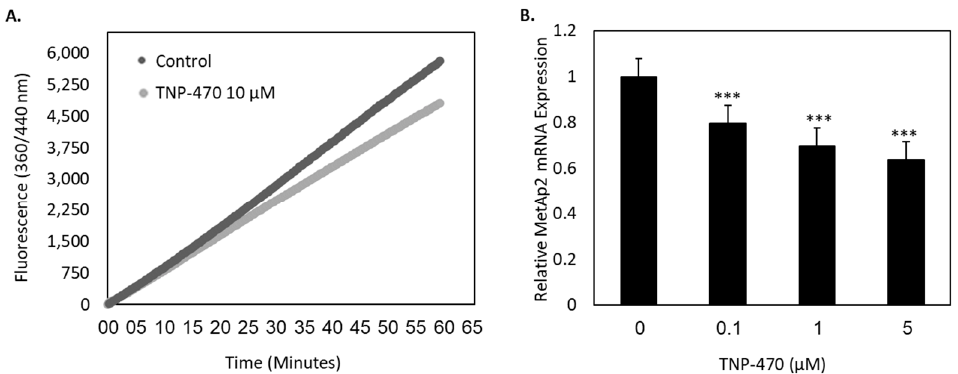
Figure 3. MetAp2 inhibition a ff ects the activity and expression of MetAp2 in LECs. ( A ) The addition of 10 µ M TNP-470 treatment inhibits the enzymatic activity of MetAp2 by 23% over the course of 2 h, n = 2. ( B ) HMVEC-dLyAd cells were treated with 0, 0.1, 1 and 5 µ M of TNP-470, and the MetAp2 mRNA levels were measured after 4 h of incubation using qRT-PCR. The inhibition of MetAp2 reduced the MetAp2 mRNA expression levels to 64%, 70% and 80%, respectively. n = 3. *** p <